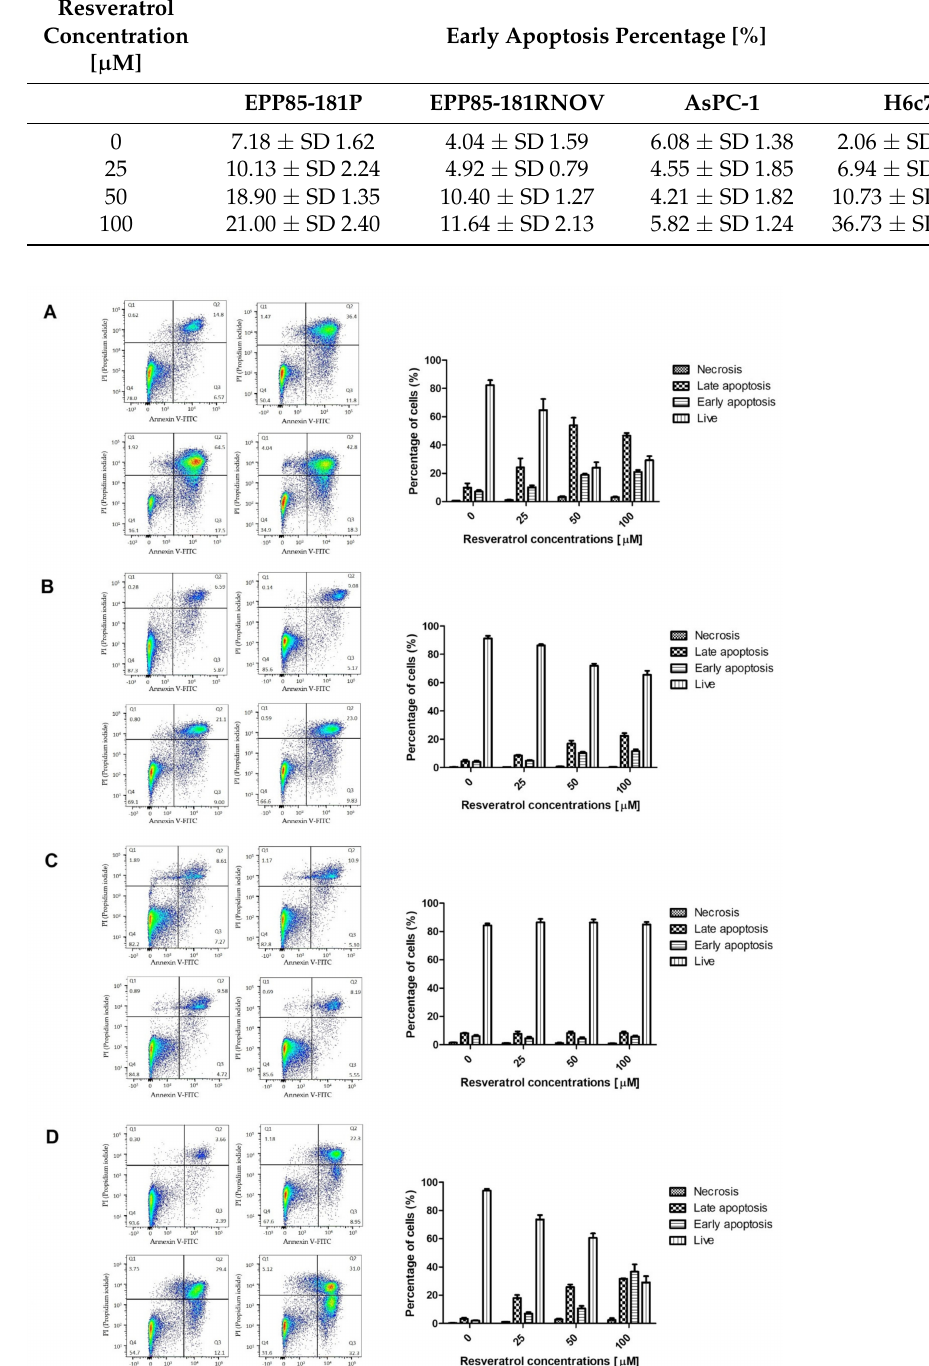
Table 2. Apoptosis percentage in neoplastic and normal pancreatic cells induced by resveratrol. Results are presented as mean of triplicate measurements.